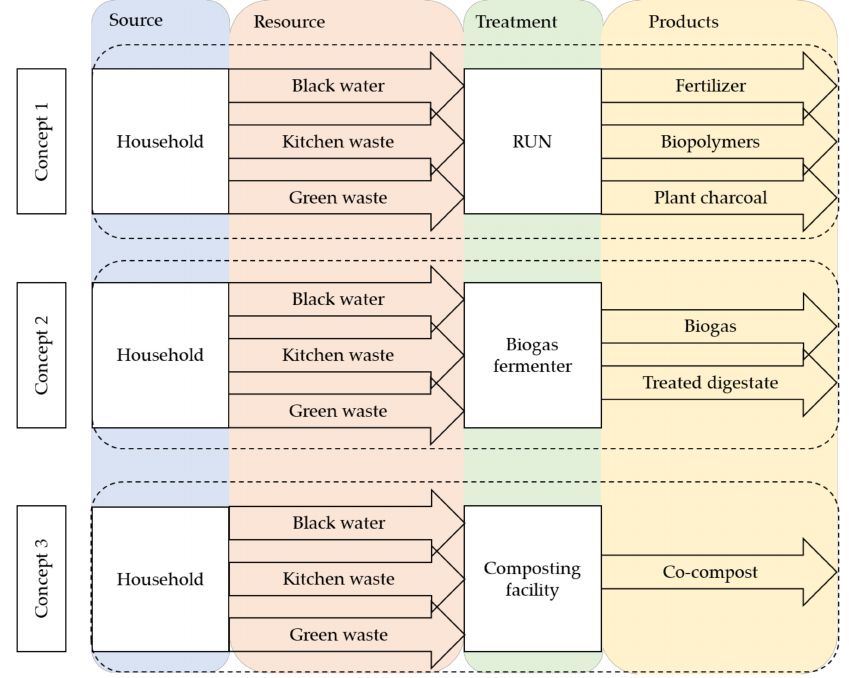
Figure 2. The three co-recycling concepts considered for the thematic online expert